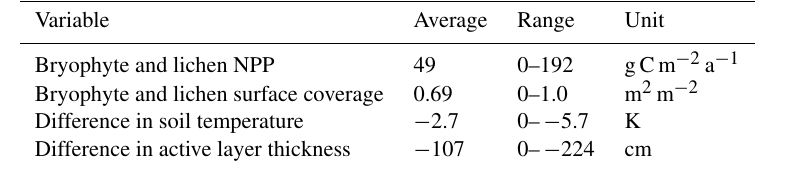
Table 1. Net primary productivity (NPP) and surface coverage of the simulated dynamic bryophyte and lichen layer, as well as differences between the Dynamic and Without simulations with regard to topsoil temperature and active layer thickness. The values are based on the last 15 years of 1901 to 2010 transient simulations and the region considered is limited to boreal forest and tundra. g C stands for “gram carbon”. Variable